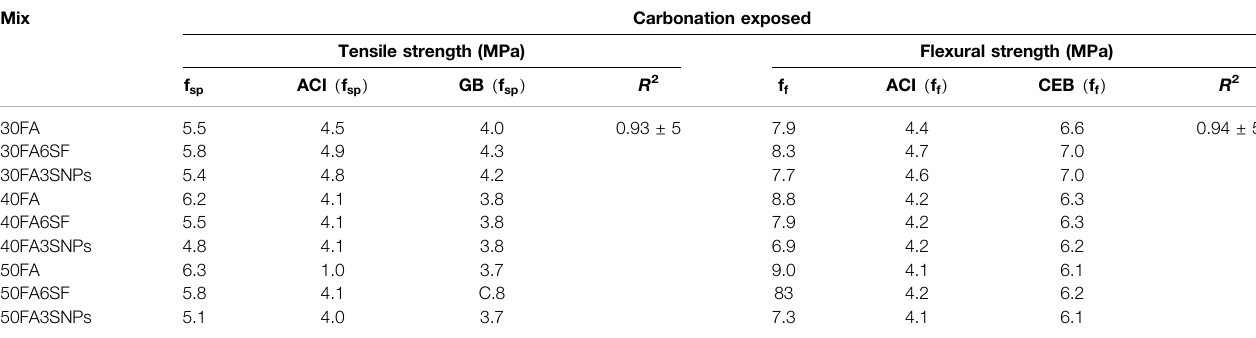
TABLE 5 | The split tensile and fl exural strength of carbonation exposed 30%, 40%, and 50% fl y ash containing 3% SNPs and 6% SF incorporated concrete samples compared with standard model strength after 365 days of exposure.